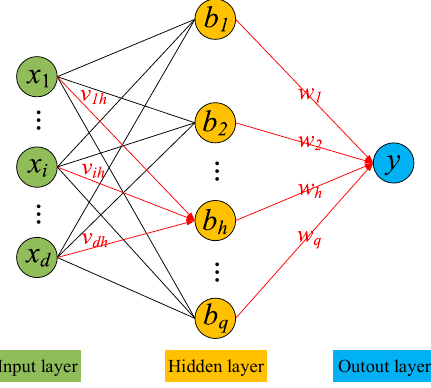
Figure 2. Structure of back propagation (BP) network.